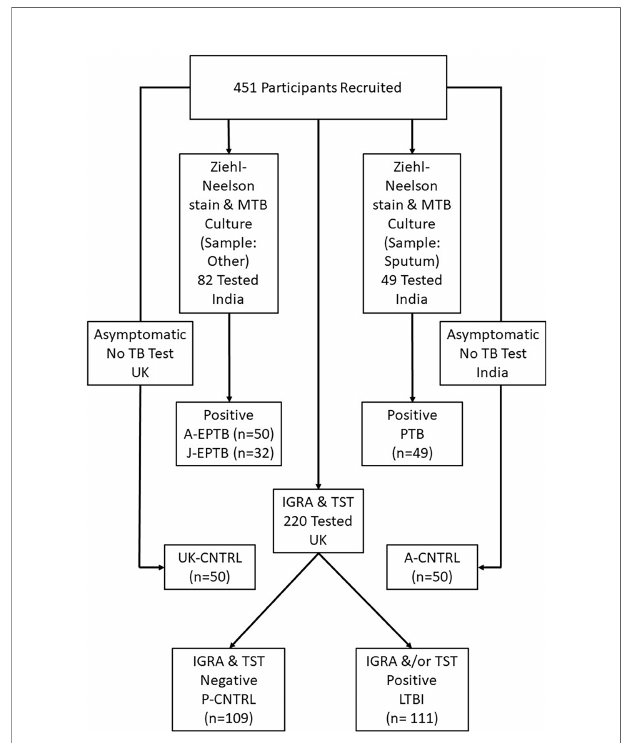
FIGURE 1 | Flowchart of patient and control cohort used in the